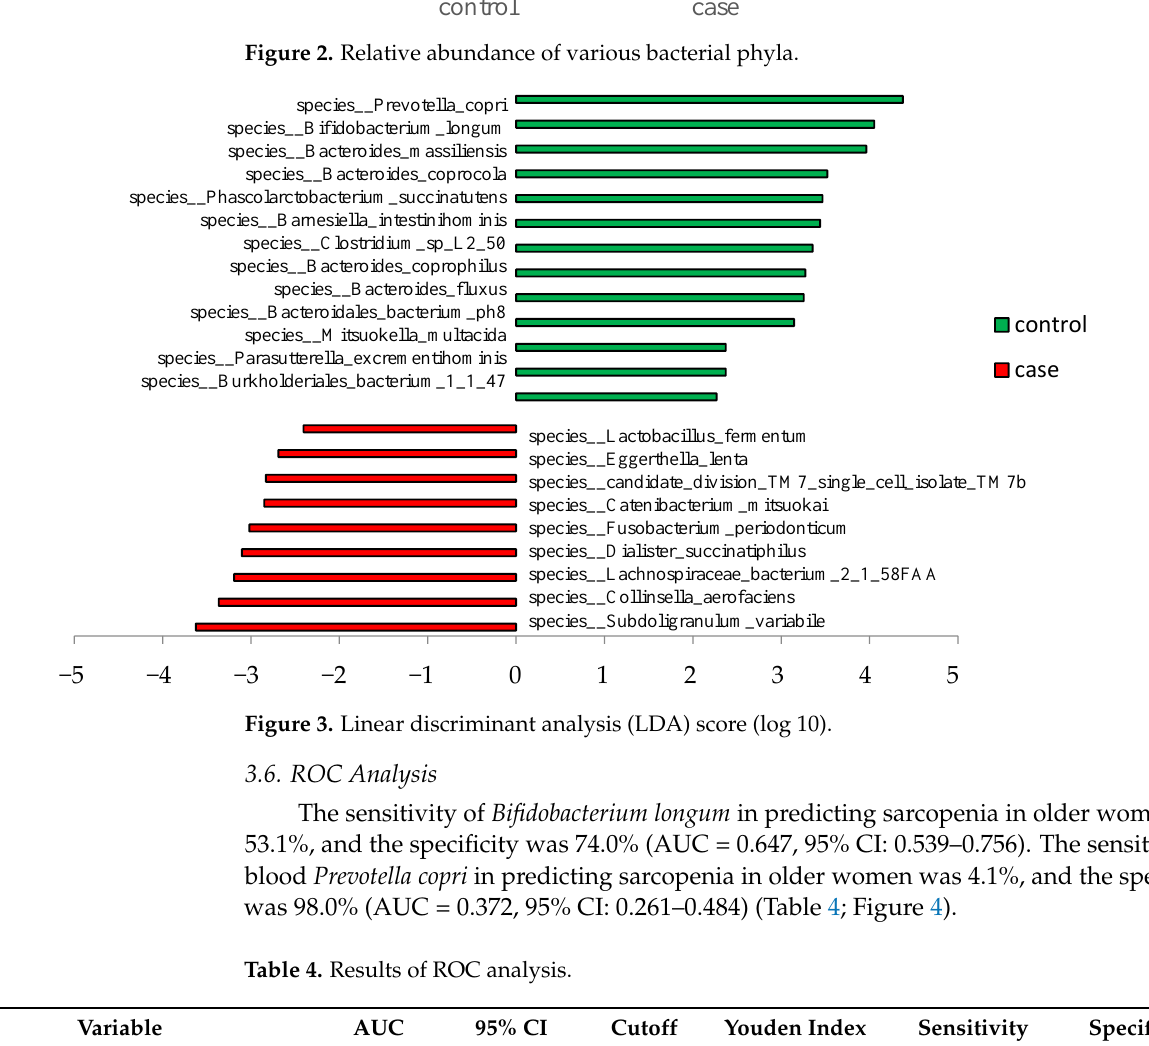
Figure 3. Linear discriminant analysis (LDA) score (log 10).